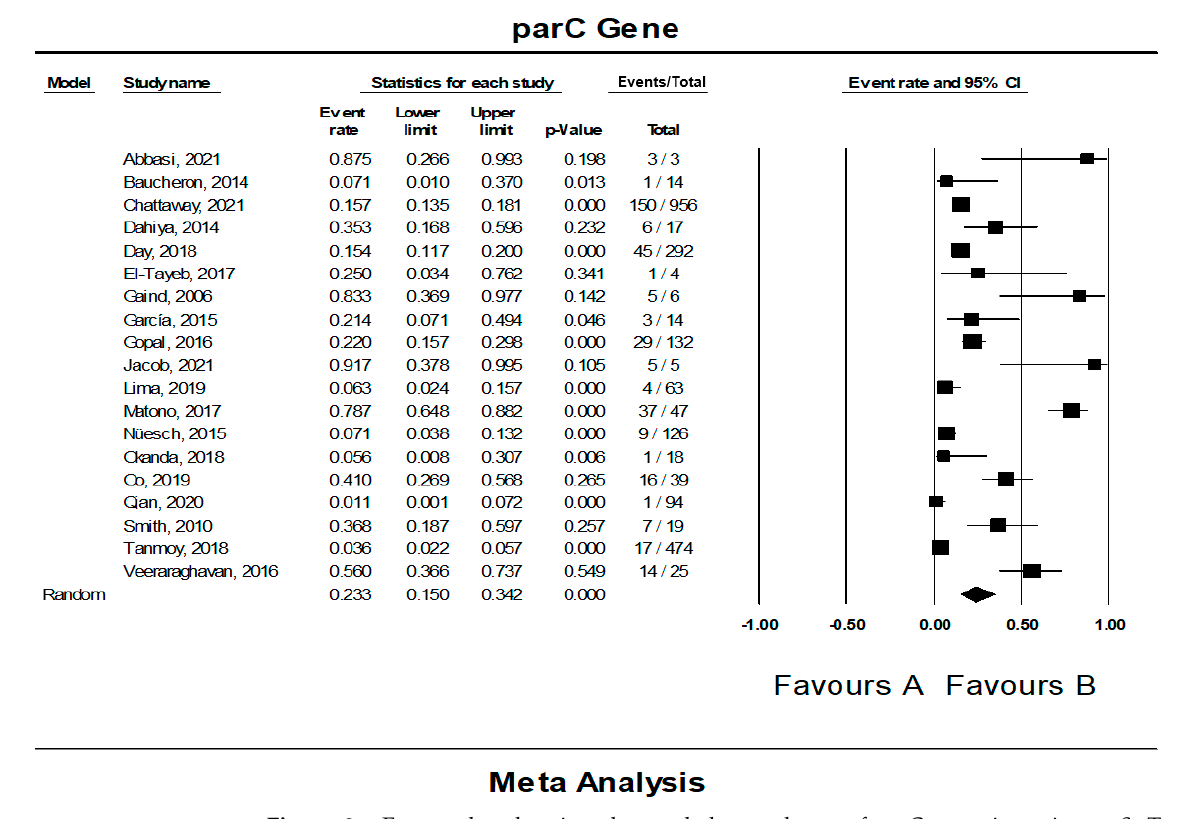
Figure 9. Forest plot showing the pooled prevalence of parC gene in resistant S. Typhi isolates estimated by a random effect model of meta-analysis. (23.3%, I 2 : 91.26, 95% CI: 15.0–34.2, p -value < 0.001) [12,22,24,25,27,29,31,32,35,36,38 − 42,47,49,50].